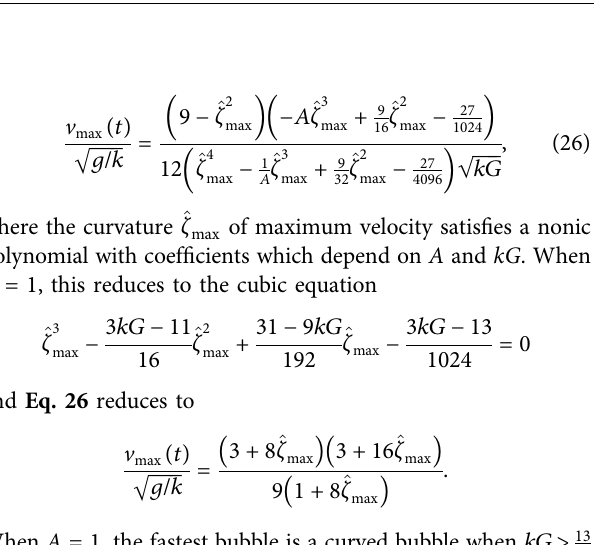
FIGURE 3 | Bubble velocity as a function of shear for various acceleration strengths when A (cid:1) 1, and various Atwood numbers when kG (cid:1)